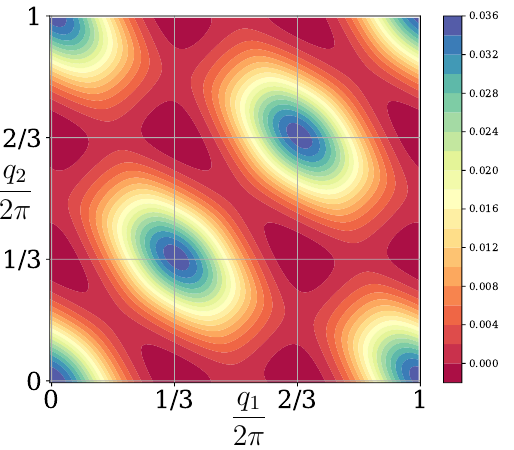
for N = 3 as c 2 − loop , Ω 0 F